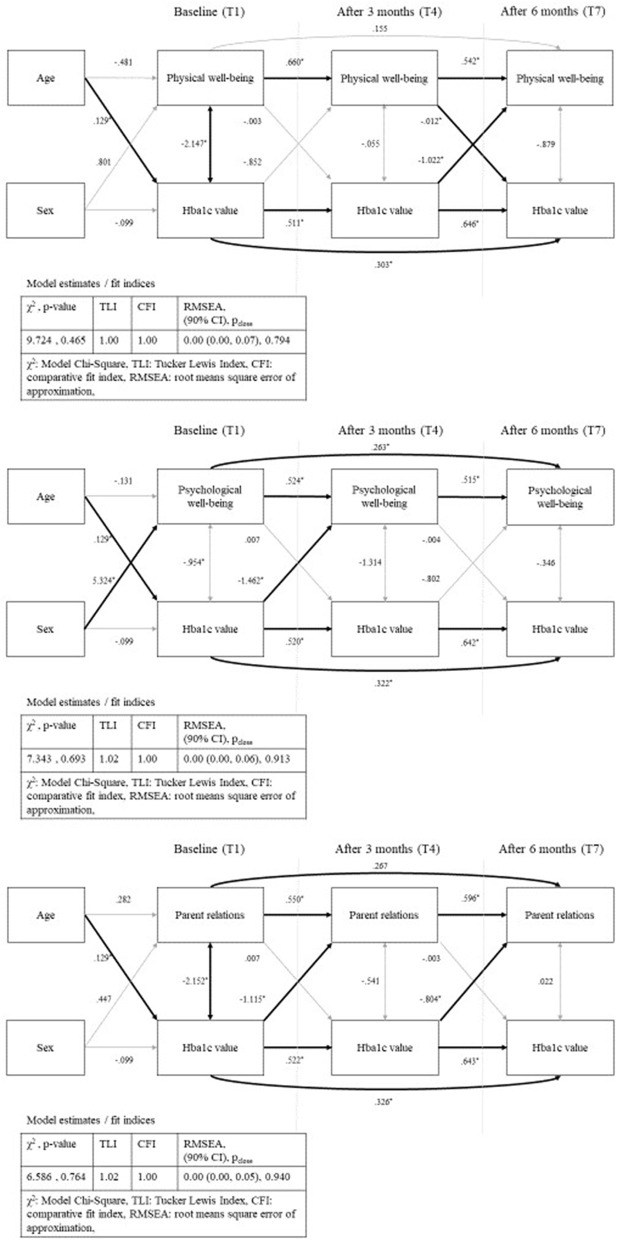
Path analysis—physical well-being, psychological well-being and parent relations with standardized parameter estimates and model fit indices; bold arrows show statistical significant paths (p < 0.05); sex as dichotomous variable (male).